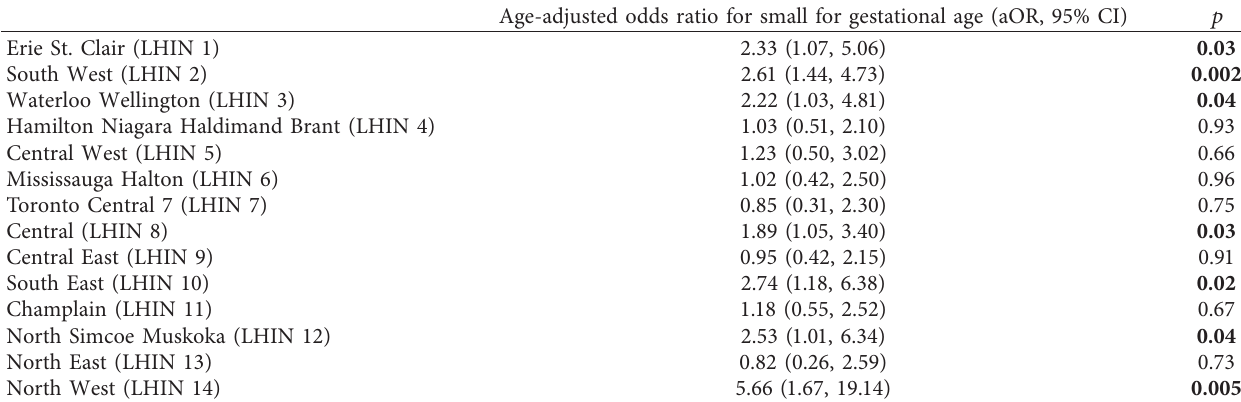
Bold p values demonstrate statistical